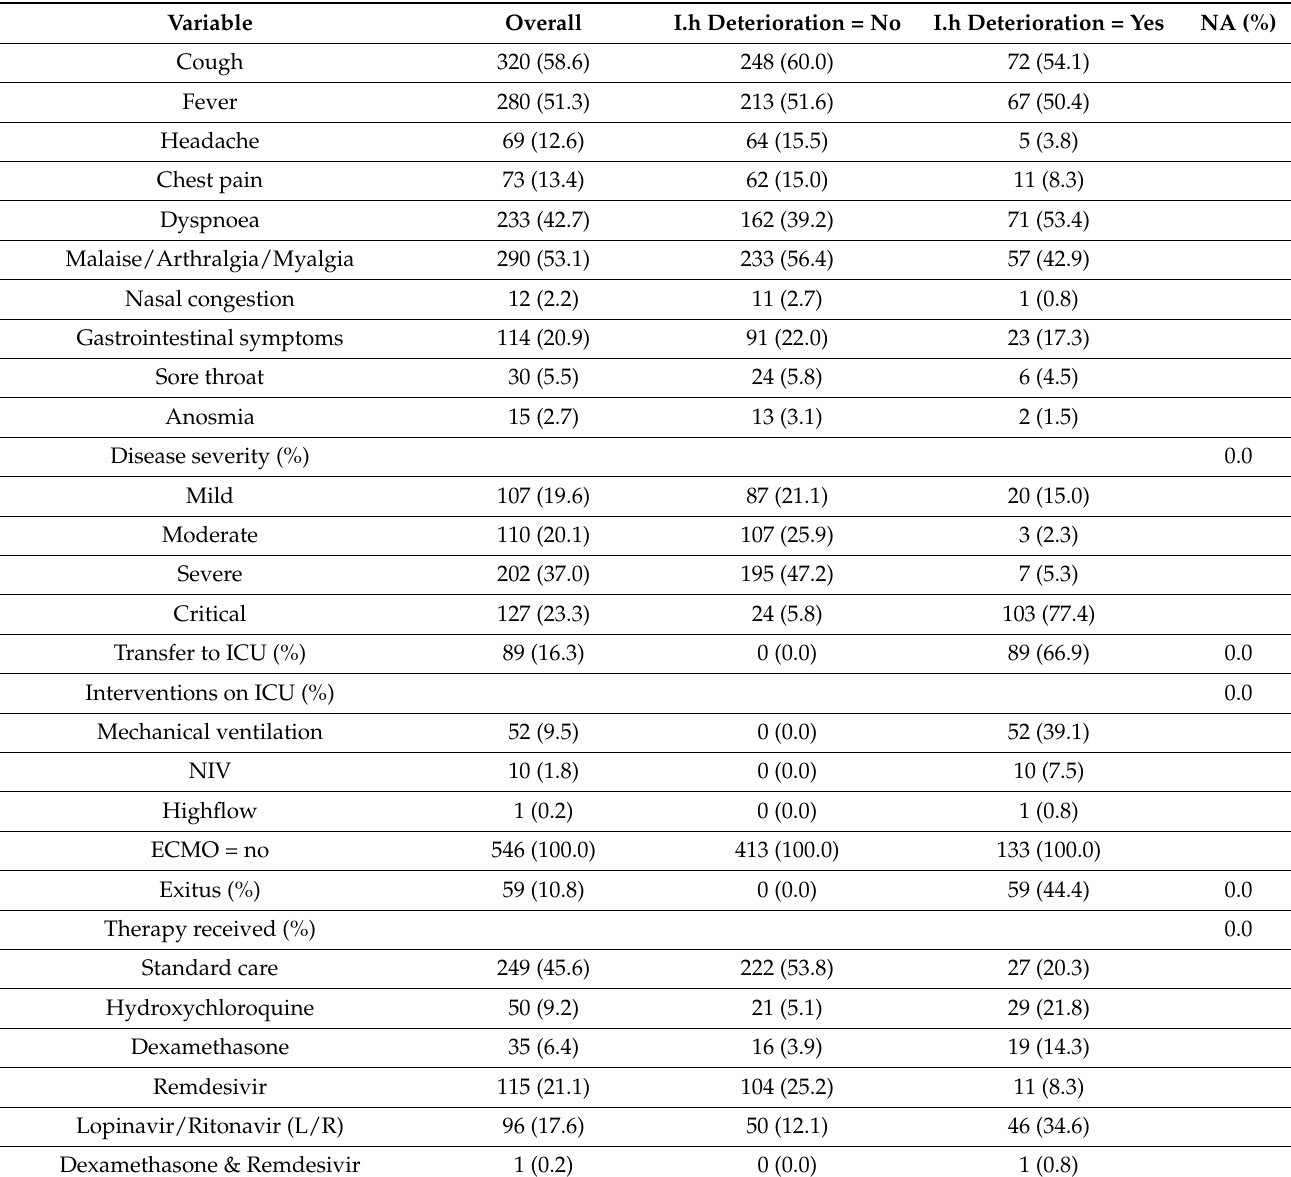
(Table 2), which is slightly better than the discriminatory performance of the model when applied to the original derivation cohort (AUC = 0.76 (95% CI from 0.75 to 0.77)). The 4C Deterioration Model overestimated the risk of in-hospital deterioration on average, and the risk predictions varied too little (calibration intercept = − 0.39 ( − 0.60 to − 0.18), slope = 1.30 (1.02 to 1.58)) (Figure S1). A slope larger than the reference value 1